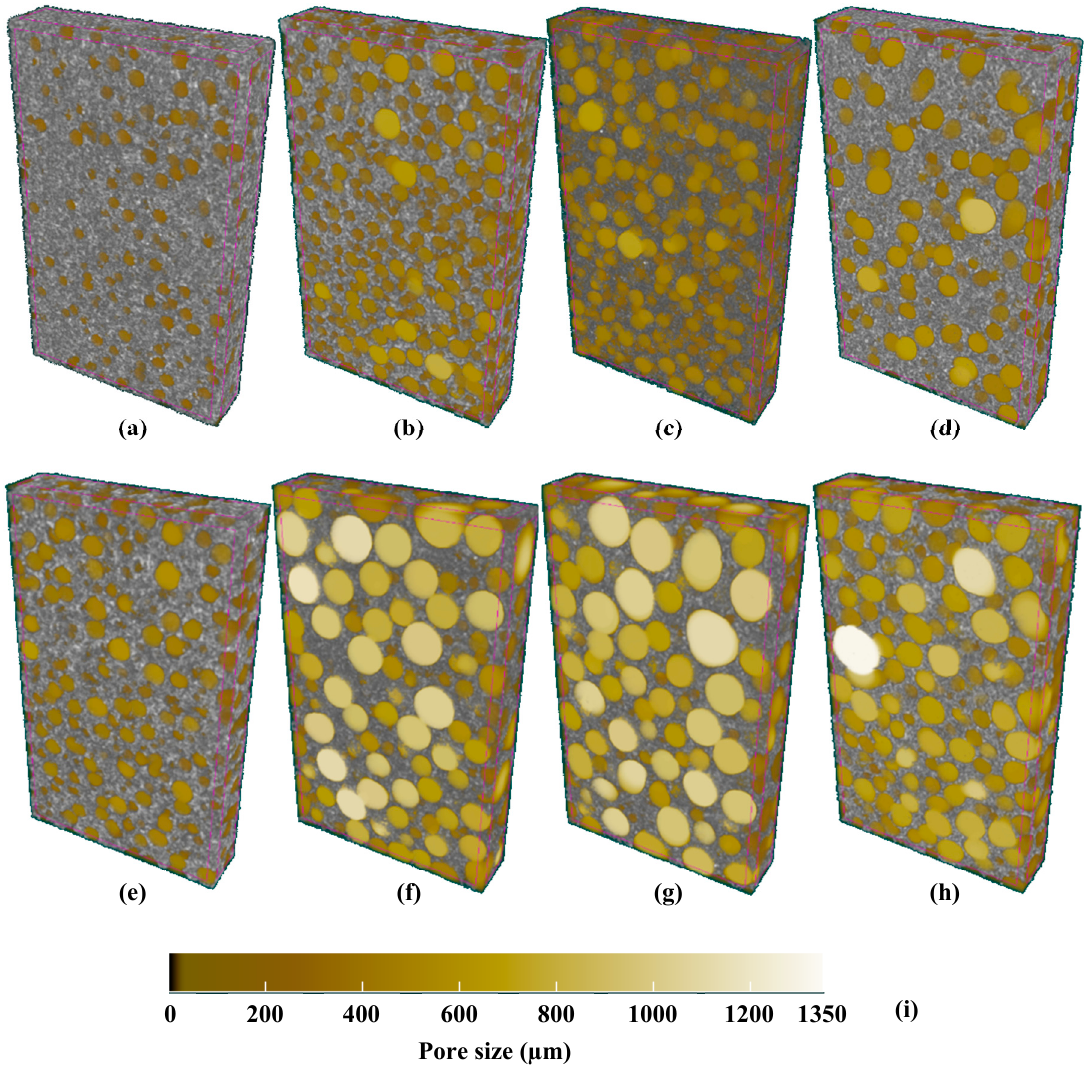
Figure 5. 3D images of CSR/epoxy composite foam adhesives: ( a ) CSR 0/FA 0.1, ( b ) CSR 5/FA 0.1, ( c ) CSR 10/FA 0.1, ( d ) CSR 20/FA 0.1, ( e ) CSR 0/FA 1, ( f ) CSR 5/FA 1, ( g ) CSR 10/FA 1, and ( h ) CSR 20/FA 1. ( i ) Color scale indicator for pore size (FA = Foaming agent).